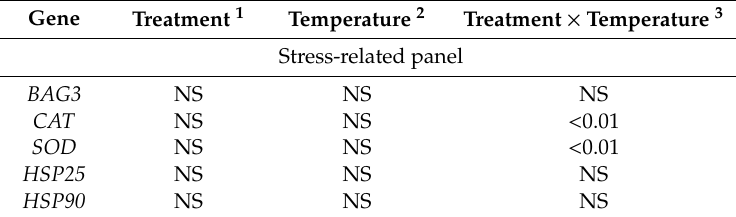
E ff ects: 1 In ovo delivery of galactooligosaccharides (GOS) vs. physiological saline (C); 2 ambient temperature (TN—thermoneutral vs. HS); 3 interaction between in ovo treatment and ambient temperature on immune-related